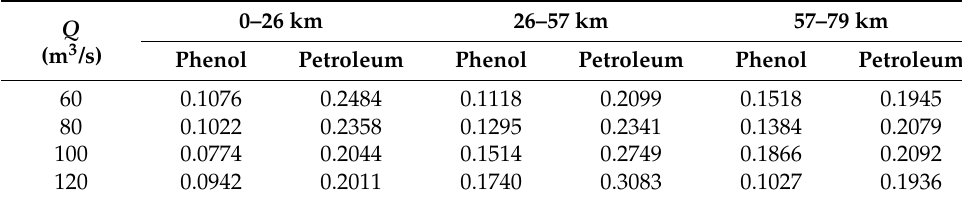
Table 9. Phenol and petroleum degradation coefficient of the L-H section (Unit: d − 1 ).